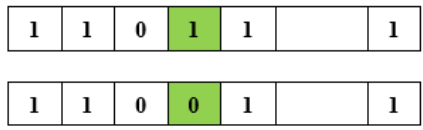
Fig. 10. Binary swap mutation operator for binary structure